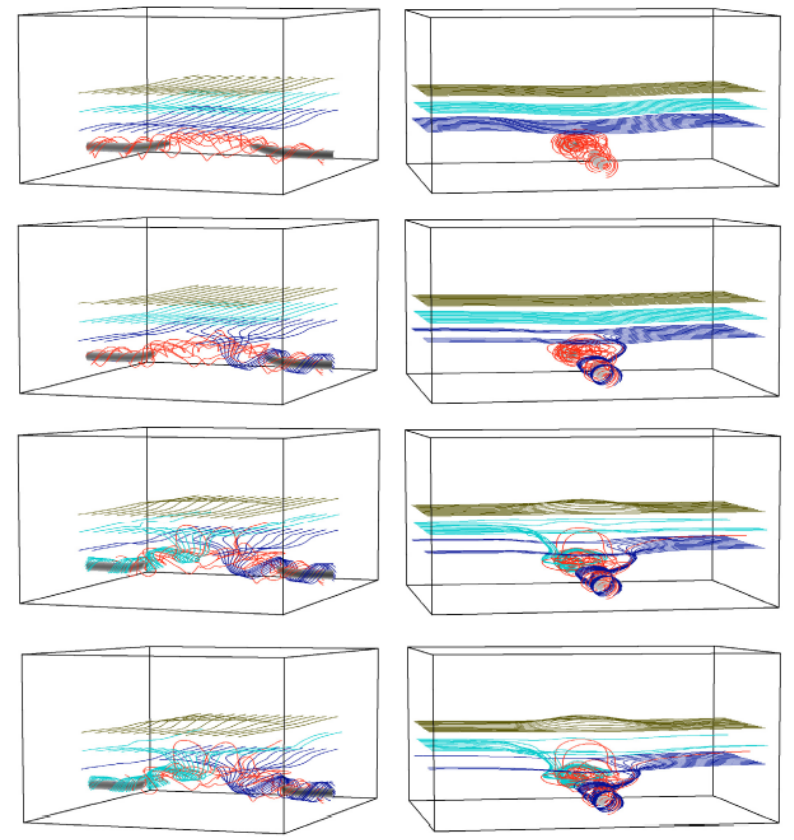
Figure 48: Time evolution of the magnetic field lines in the simulation by Archontis et al. (2004). The grey isosurfaces show the location of strong fields corresponding to the part of flux tube that remains below the photosphere. The red field lines are traced from the isosurfaces, while the other field lines are traced from the side boundaries. Image reproduced with permission, copyright by